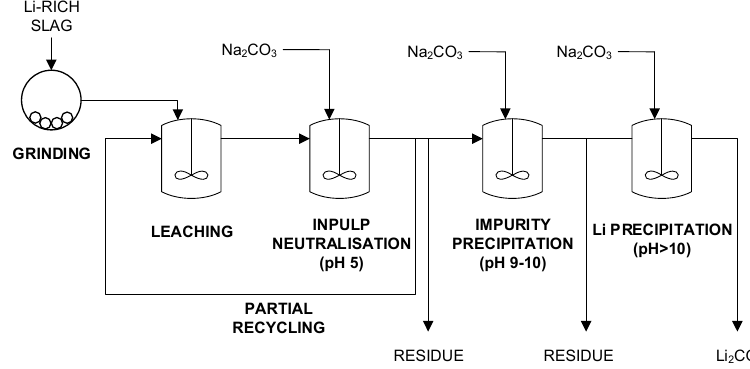
Figure 7. Simplified flowsheet for the production of Li 2 CO 3 adapted from [58].